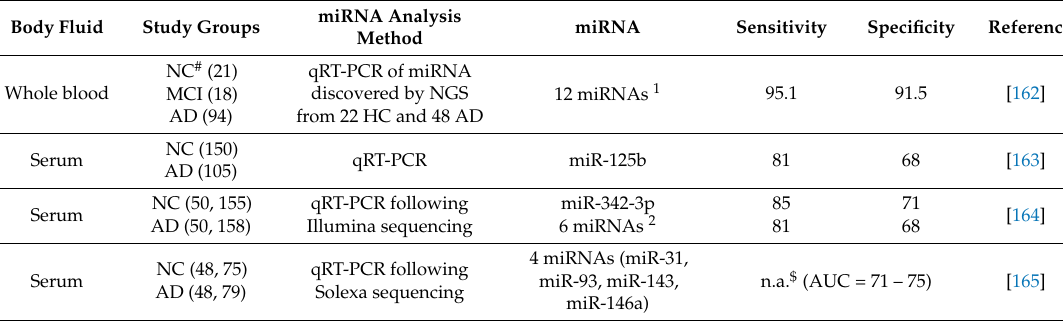
Table 1. Selected studies * using body fluids as a source of miRNA AD